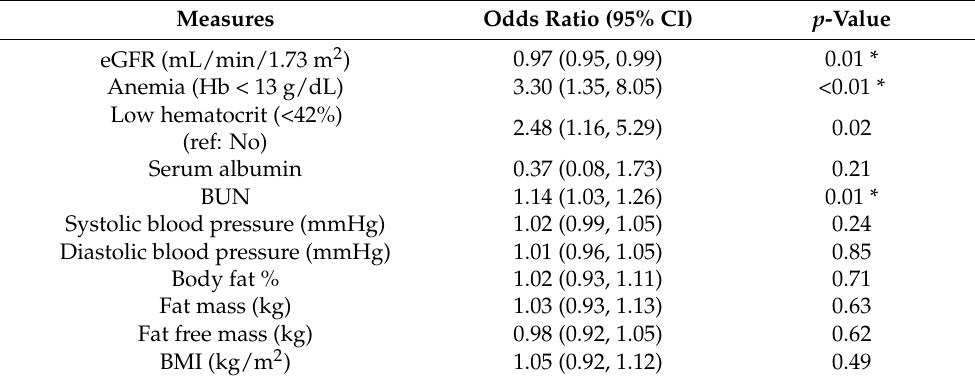
Table 6. Risk factor analysis comparing participants with elevated HbA1c (HbA1c ≥ 5.7, n = 42) versus participants with normal HbA1c (n = 161), controlling for age and origin.